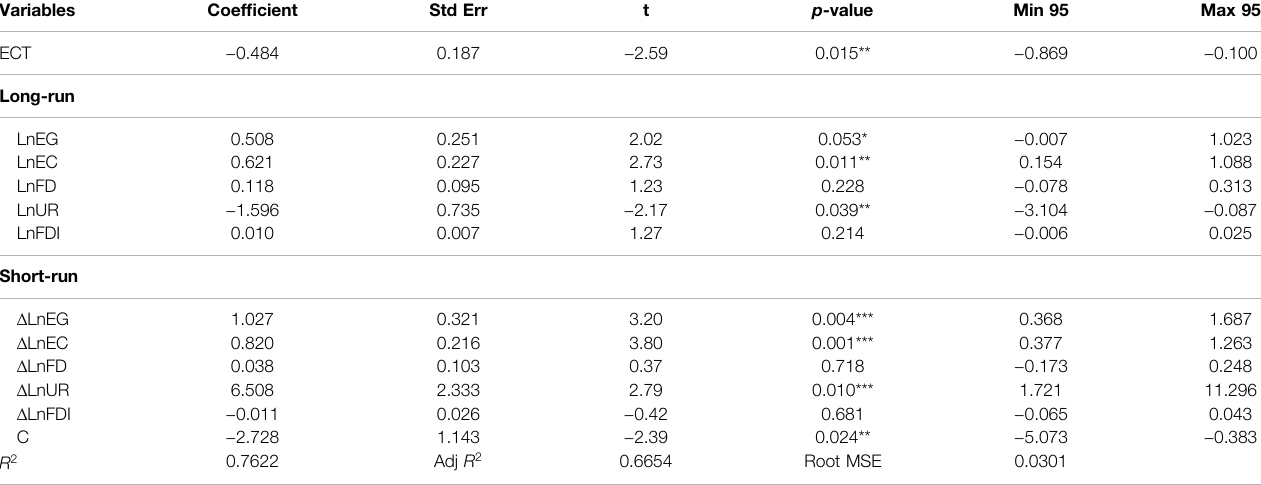
TABLE 5 | DYNARDL simulations